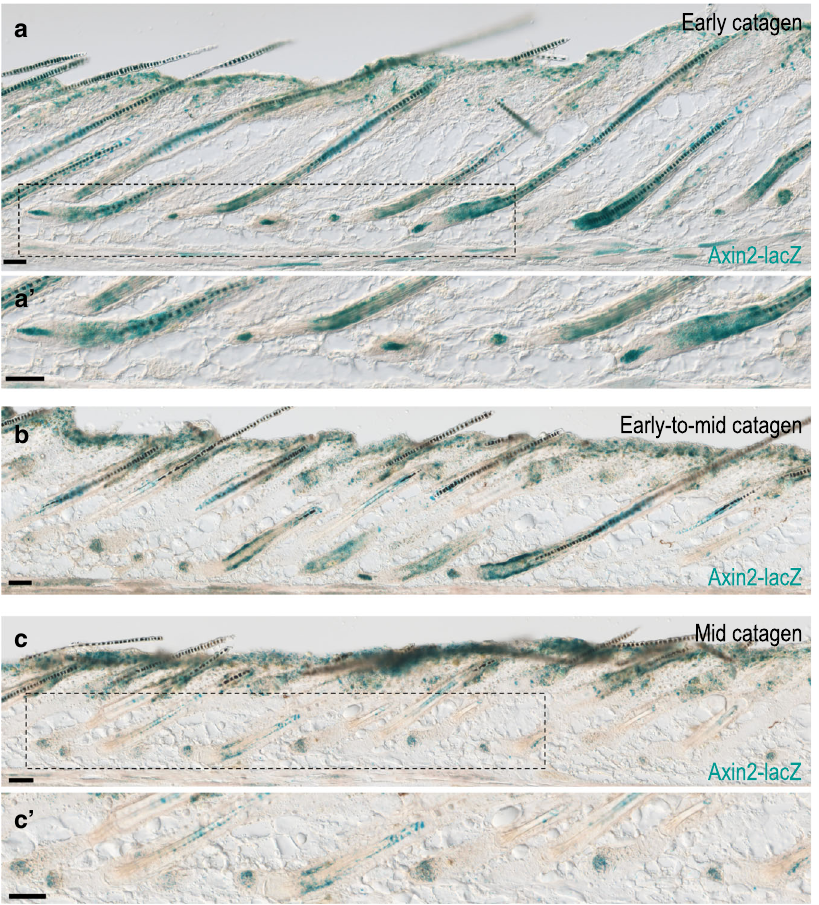
Fig. 5 Wnt signaling activity during catagen. LacZ staining of dorsal skin sections from adjacent regions along the anterior – posterior axis of a wild-type mouse at P18 are shown. a , a ′ Posterior dorsal region is displayed to illustrate the high levels of Wnt activity in the DP and the lack of Wnt activity in the epithelial part of the follicle adjacent to the DP during early catagen. In ( a ′ ), a higher magni fi cation of the fi eld demarcated by the dashed rectangle in ( a ) is presented. n = 3 mice. b Middle dorsal region is shown to demonstrate Wnt activity during early-to-mid catagen. n = 3 mice. c , c ′ Anterior region is depicted to show Wnt activity during mid catagen. In ( c ′ ), a higher magni fi cation of the fi eld outlined by the dashed rectangle in ( c ) is shown. n = 3 mice. Scale bar, 50 μ